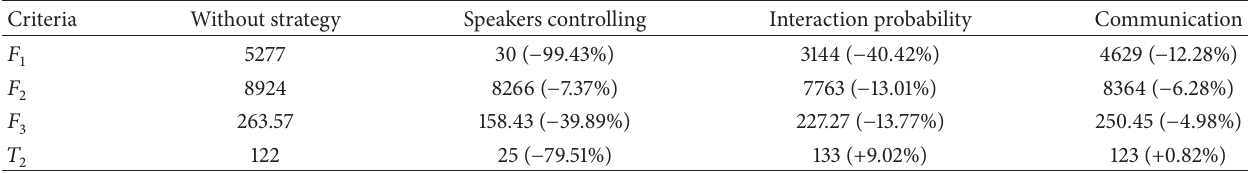
Table 7: Strategy effectiveness results of the case